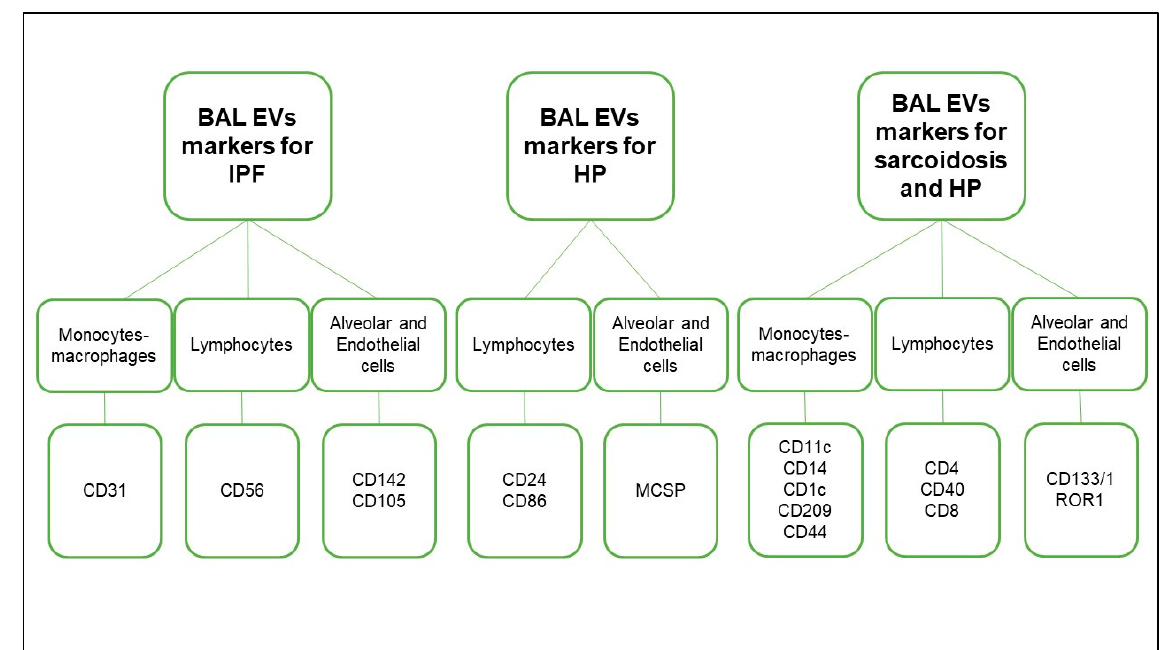
Figure 3. Heat map analysis ( a ) showed that the significant EV surface markers may be expressed in clusters of IPF, HP and sarcoidosis; blue to red through white (Blue: − 1 / White: 0 / Red: 1). The median APC (allophycocyanin) values of each significant different surface marker in IPF, HP and sarcoidosis were reported in ( b ). Abbreviations: CD-, cluster of differentiation; IPF, idiopathic pulmonary fibrosis; HP, hypersensitivity pneumonitis. samples.